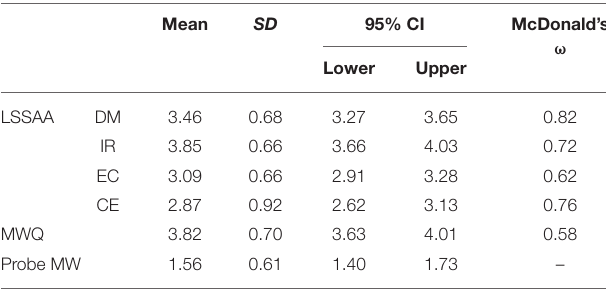
TABLE 1 | Descriptive statistics for each study variable ( n =